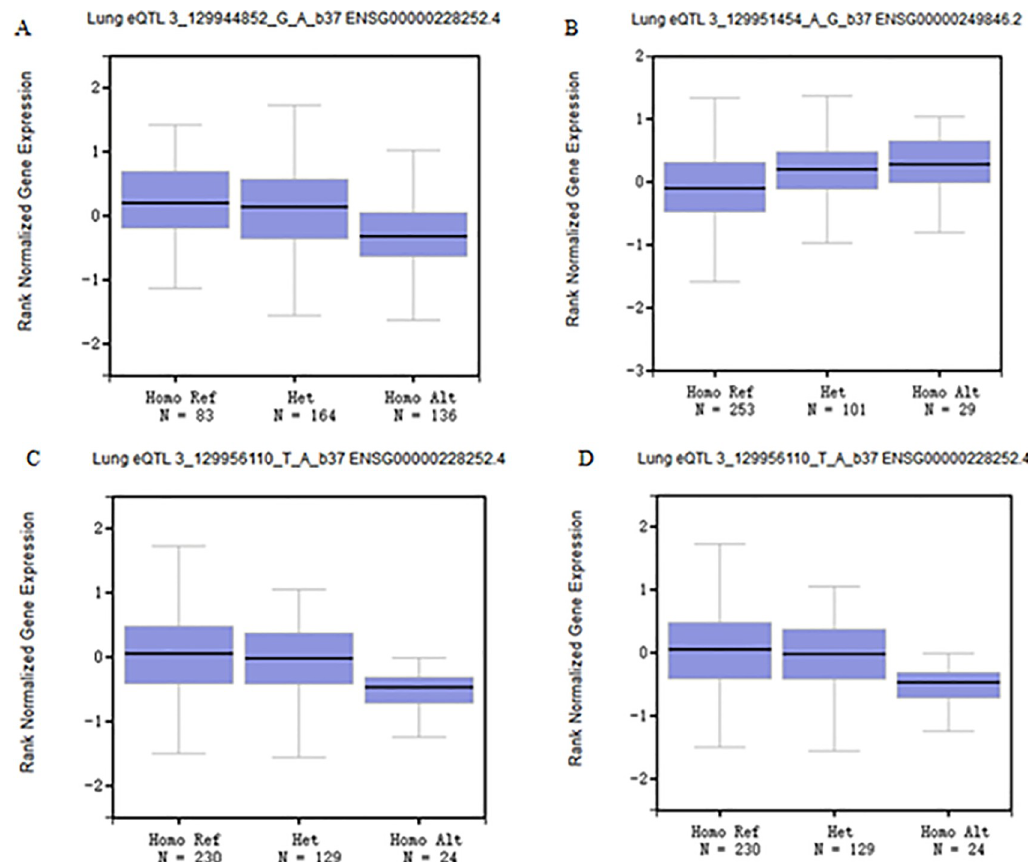
Fig 3. Expression of COL6A4P2 SNPs in lung tissues. (A) Expression of rs34445363 genotype in the lung ( p = 5.80 × 10 − 14 ); (B) Expression of rs7625942 genotype in the lung ( p = 8.90 × 10 − 8 ); (C) Expression of rs77941834 genotype in the lung ( p = 1.60 × 10 − 5 ); (D) Expression of rs61733464 genotype in the lung ( p = 1.00 × 10 − 9